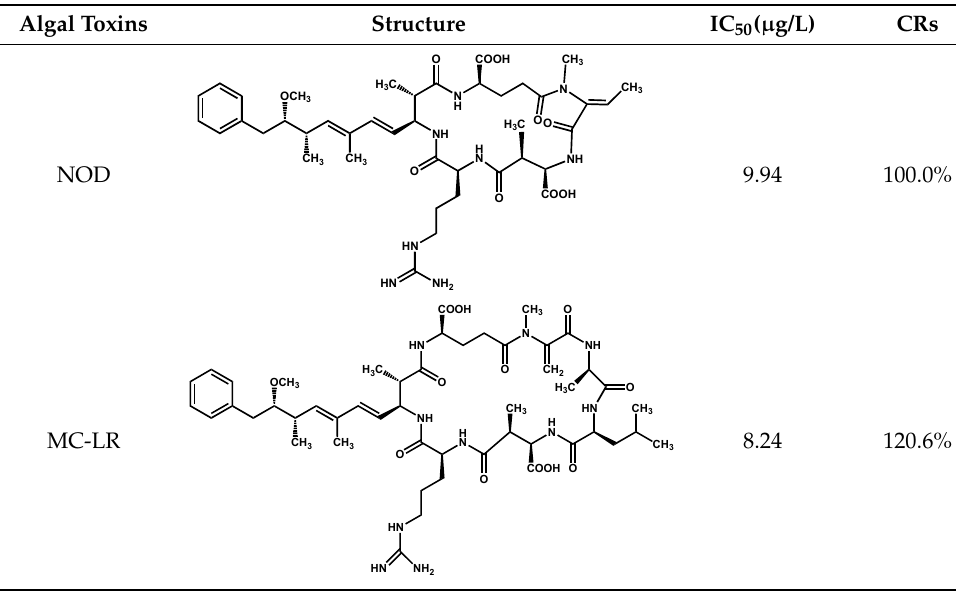
Figure 7. Standard curves of ic-ELISA for NOD-R based on purified N56 under the optimized reaction conditions. The standard curves were normalized by expressing the experimental absorbance values (B) as B/B 0 , where B 0 is the absorbance value at zero analyte concentration ( n = 3). Besides, the N56-based assay showed relatively significant cross reactivity for MCs.